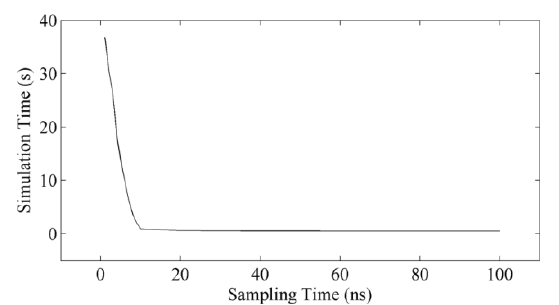
Figure 6. Lightning channel base current estimation algorithm timing